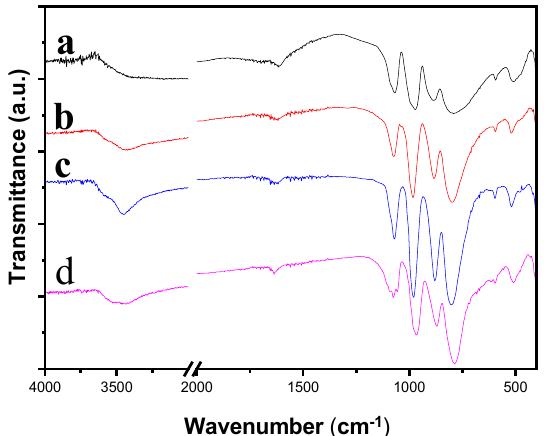
Figure 2. Fourier transform infrared spectra of H 6 PV 3 MoW 8 O 40 ( a ); CsH 5 PV 3 MoW 8 O 40 ( b ); Cs 2 H 4 PV 3 MoW 8 O 40 ( c ); and Cs 3 H 3 PV 3 MoW 8 O 40 ( d ).